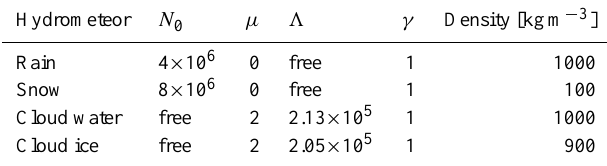
Table A1. Details of the particle size distributions and particle den- sities used with Mie spheres in RTTOV-SCATT. All units are SI and the parameters refer to the modified gamma distribution given by Petty and Huang (2011). Particle dimension is the diameter of the Mie sphere, not its melted equivalent.